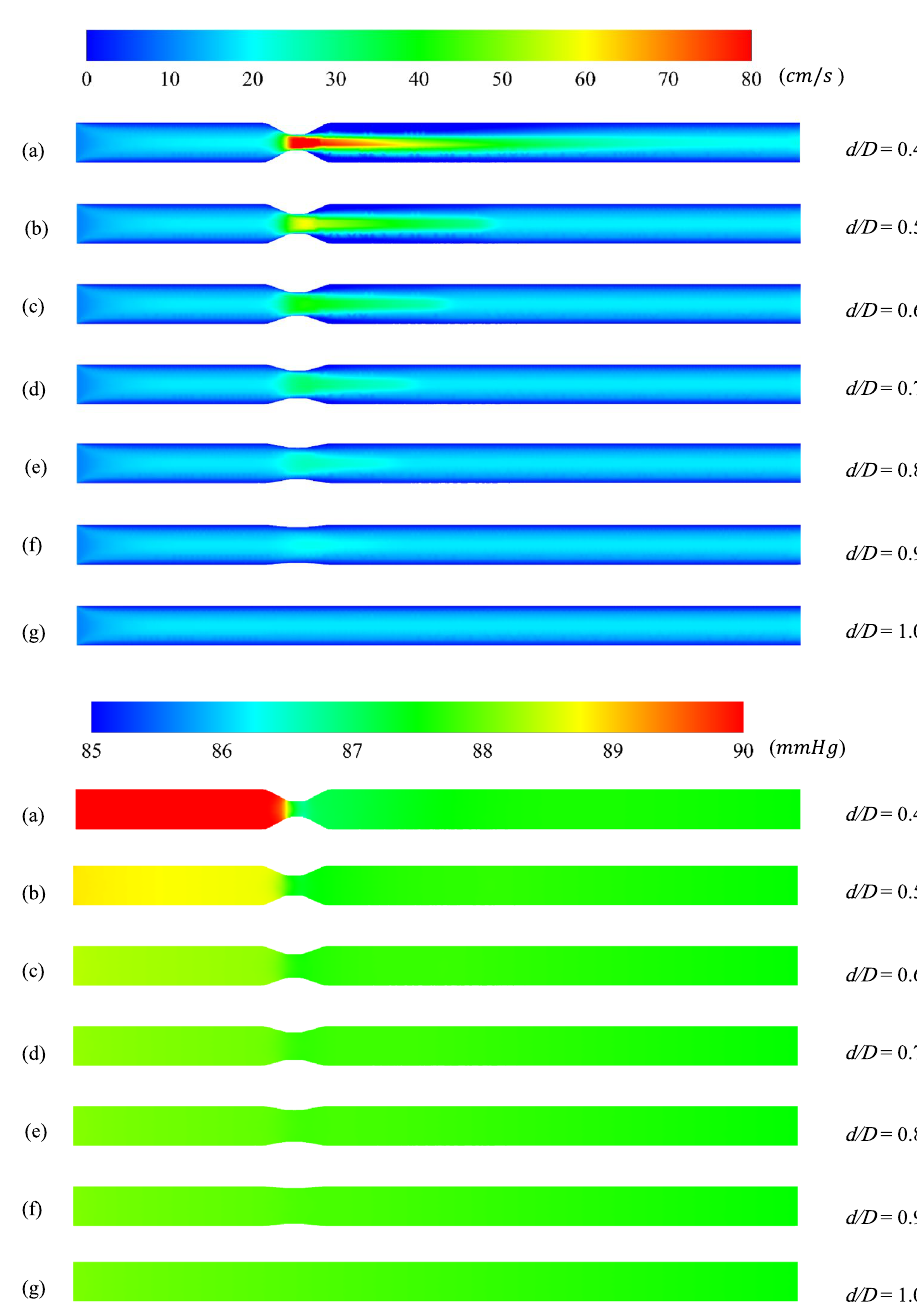
Fig. 6 Pressure distribution for case 1at different